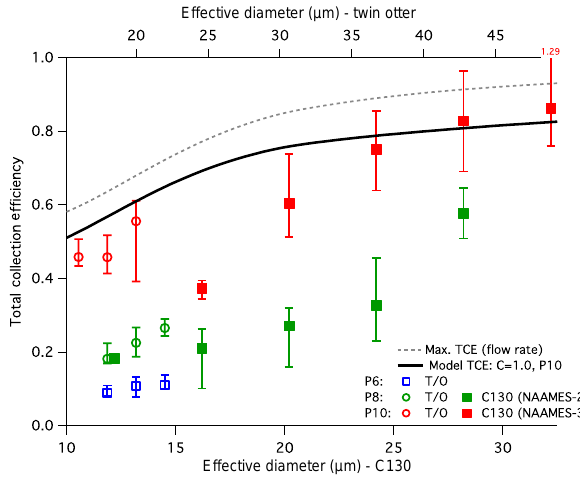
Figure 9. Bulk performance estimate across the NAAMES-2, FASE and NAAMES-3 campaigns. Markers represent median (50%) statistics, while bars represent the 25% to 75% range. Top and bot- tom axes are scaled for Stokes number similarity between corre- sponding airspeeds on the C-130 and Twin Otter (T/O) platforms. Data are grouped into bins of effective diameter based on the range of conditions encountered in each campaign. Model predicted per- formance is shown for the P10 case together with the model pre- dicted maximum performance based solely on inlet transmission (see text for